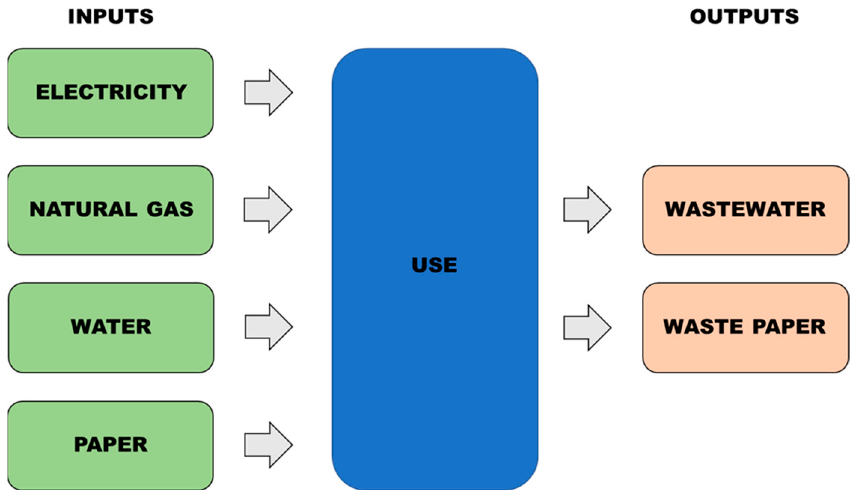
Figure 3. Material and energy flow of the system under study.